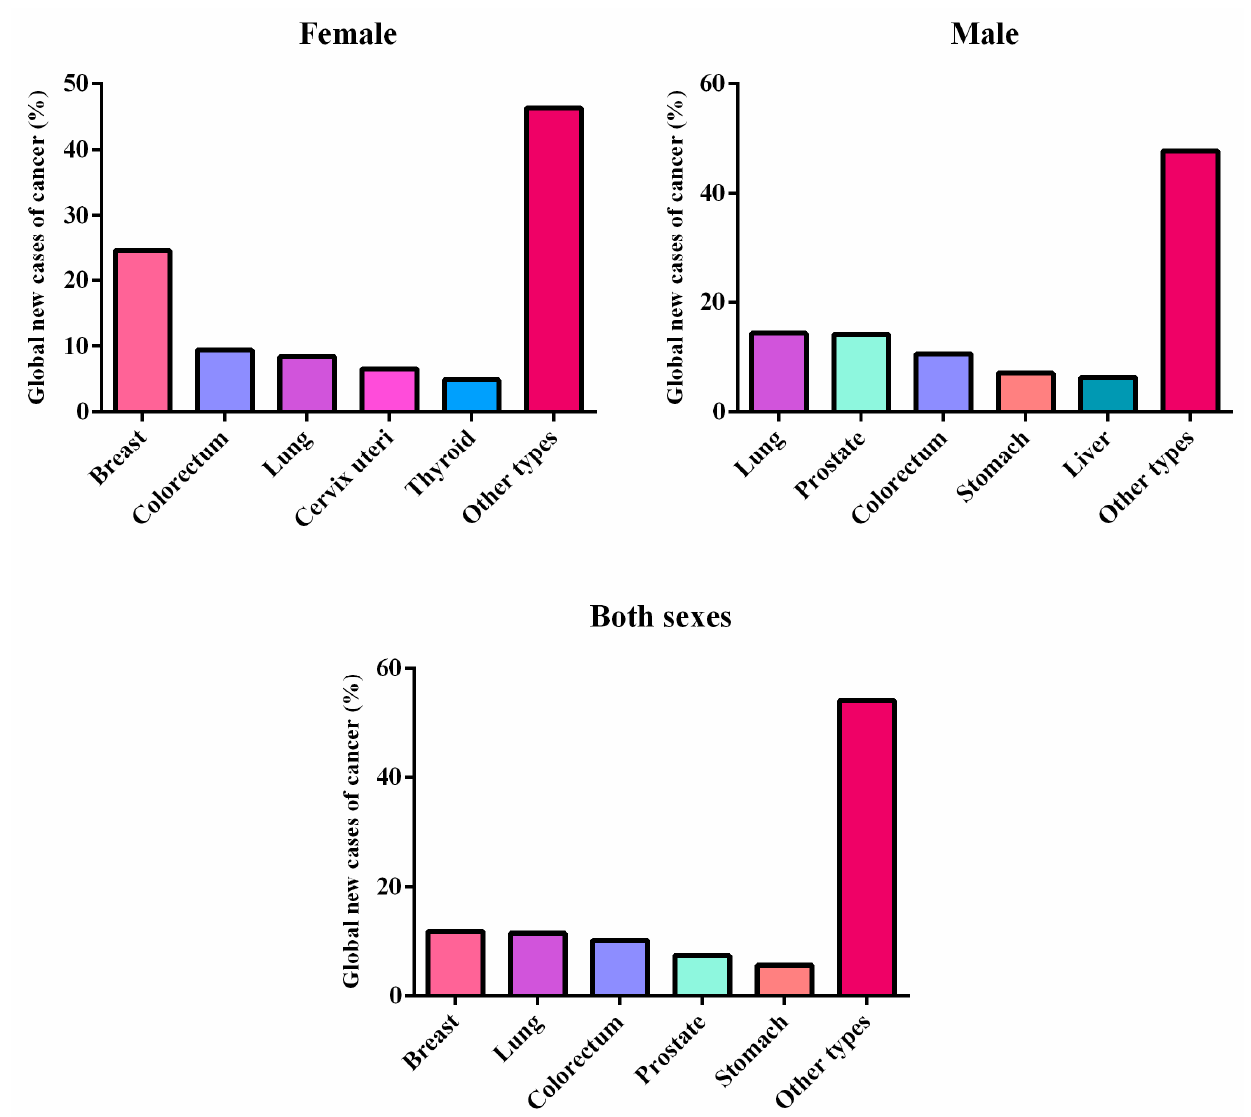
Figure 2. Incidence of global new cases of cancer (%) in 2020, according to the International Agency for Research on Cancer.